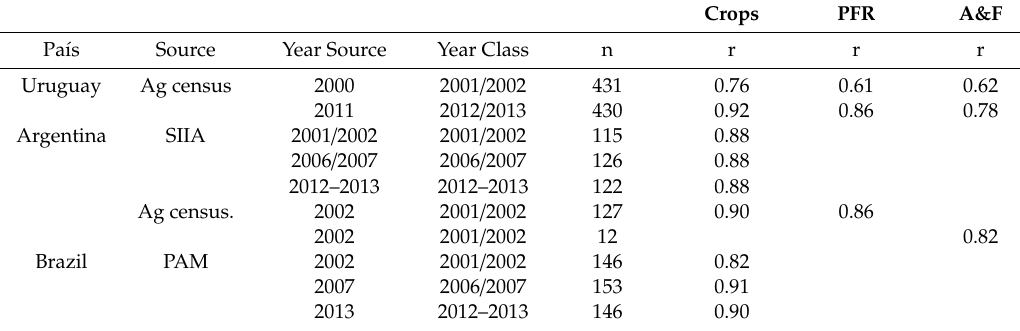
o ffi cial statistics. Ag census: agricultural censuses; SIIA: Integrated Agricultural Information